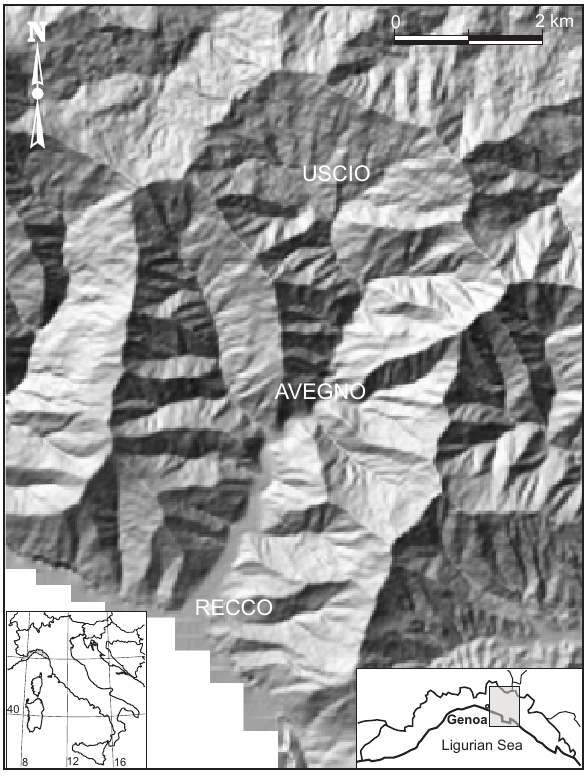
Fig. 1. Geographic sketch map of Recco Stream catchment (DTM